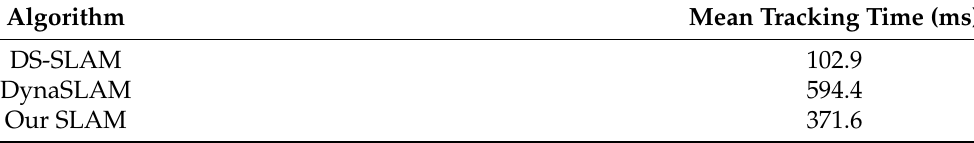
Table 8. Mean tracking time.